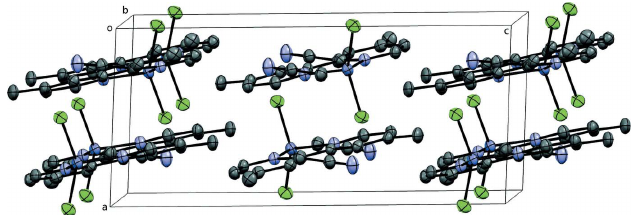
Figure 2 Perspective view of the crystal packing of the title complex approximately along the b axis; H atoms are omitted for clarity.